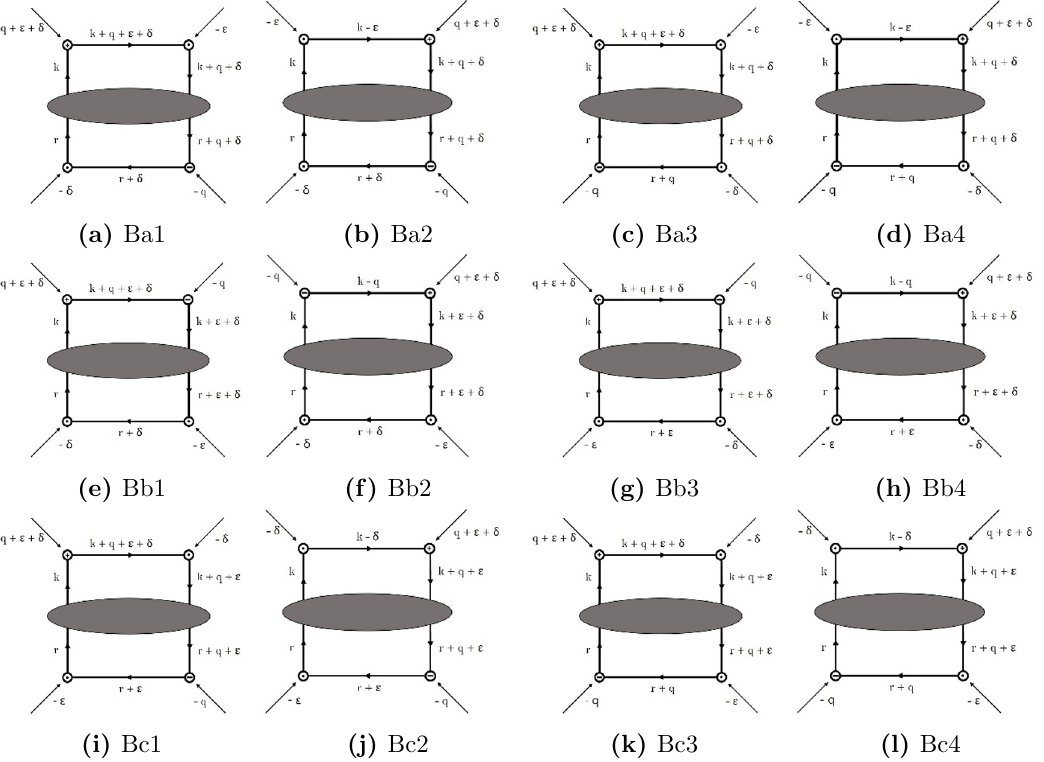
( q + (cid:15) + (cid:14) ) J (cid:0) ( (cid:0) q ) J 0 ( (cid:0) (cid:15) ) J 0 ( (cid:0) (cid:14) ) i . The ‘B’ 1 1